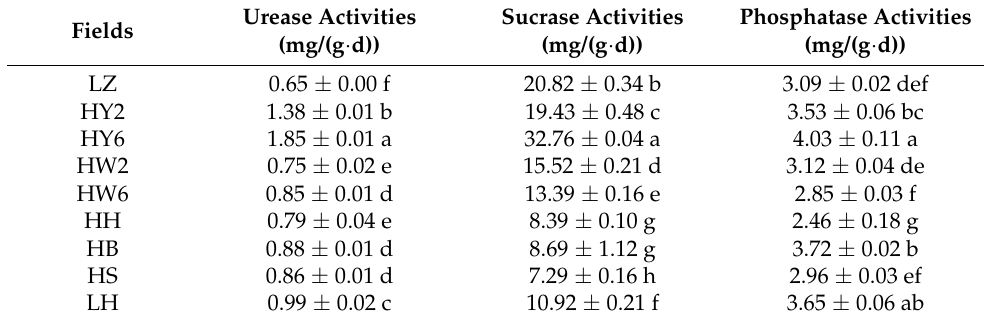
Table 3. Soil enzyme activities in different continuous cropping fields.